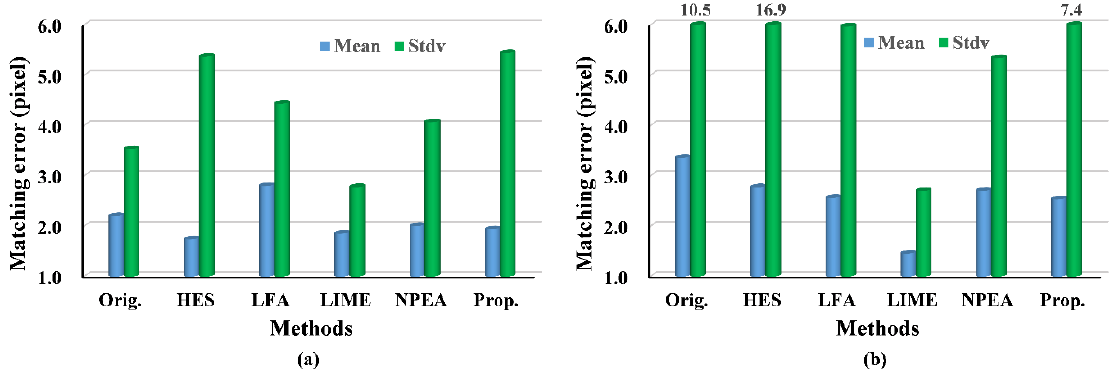
Figure 9. Histograms of matching error using SURF: ( a ) the fourth image pair; ( b ) the fifth image pair.